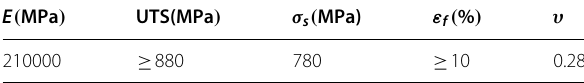
Table 3 Performance parameters of test material